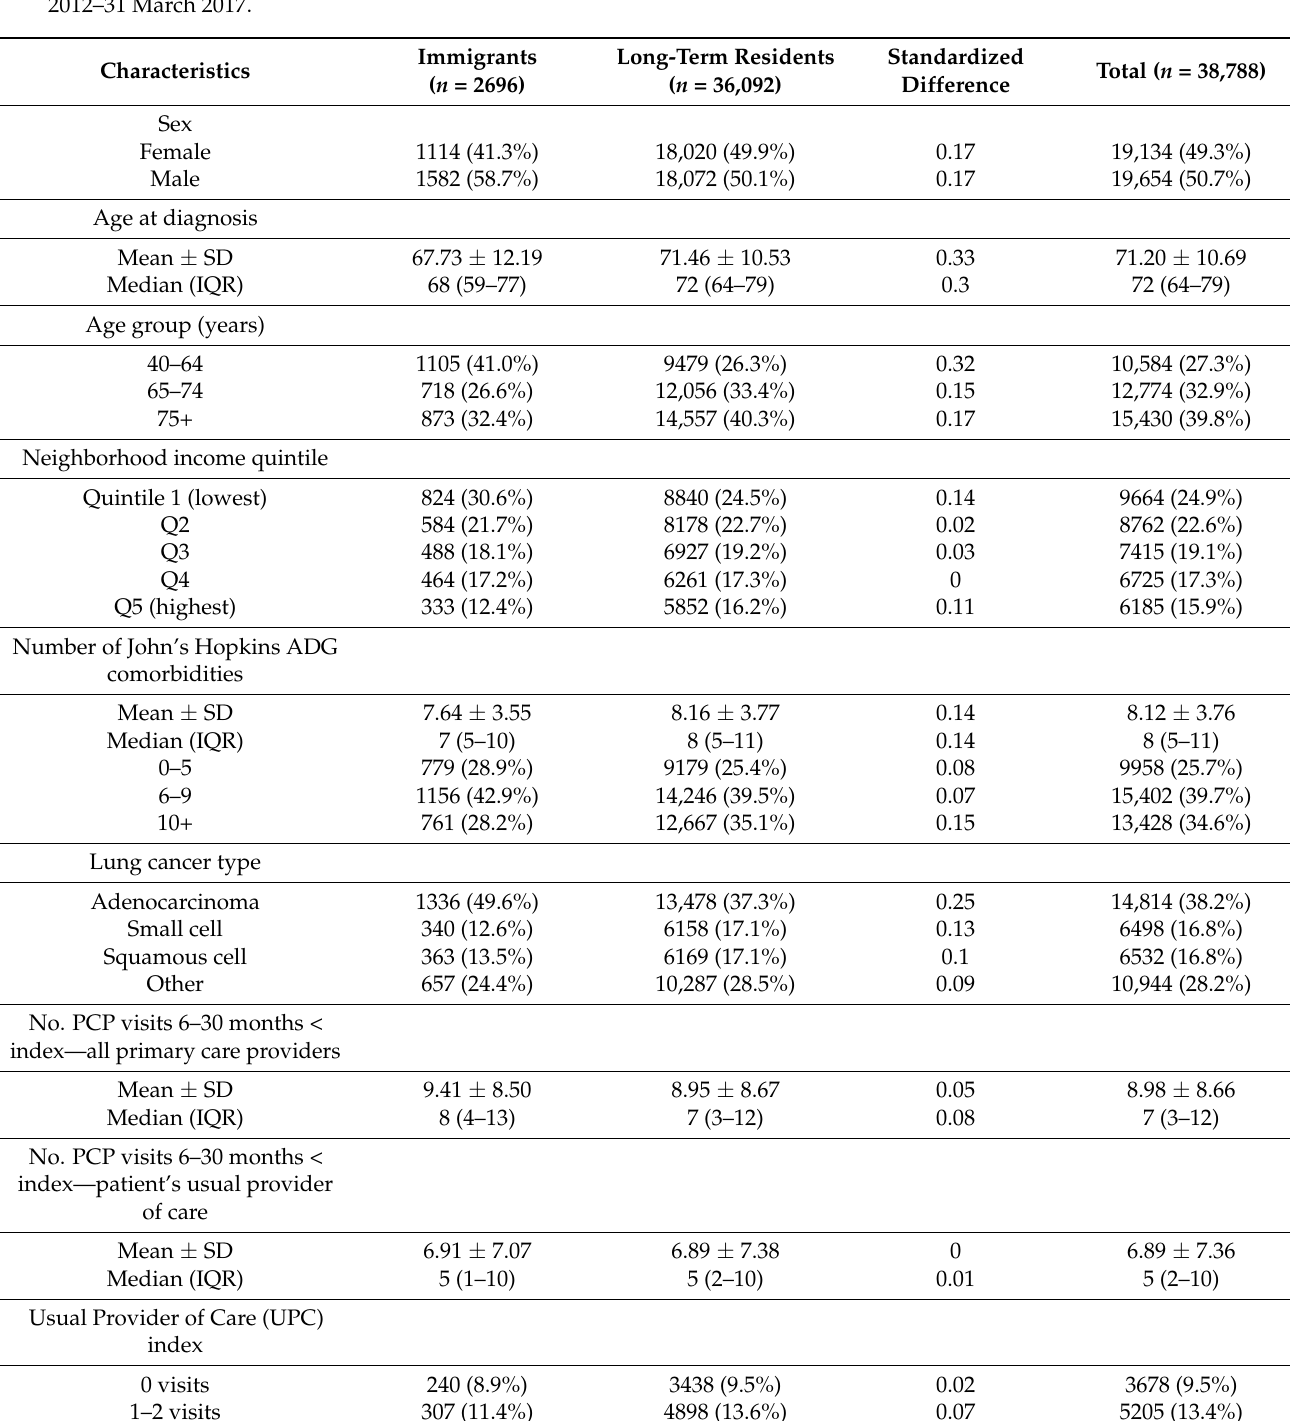
Table 1. Descriptive characteristics by immigrant status of 38,788 people in Ontario diagnosed with lung cancer, 1 April 2012–31 March